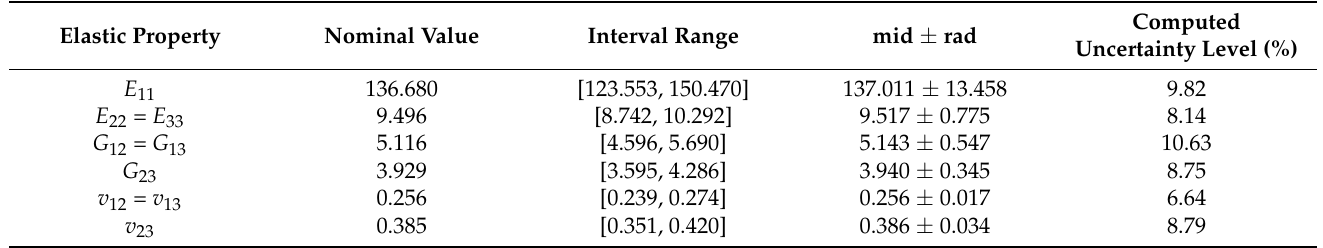
Table 5. Nominal values and computed uncertainty intervals of the AS4/3501/6 composite ply elastic properties.